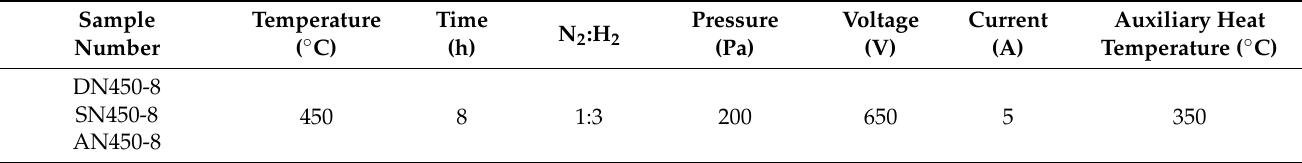
Table 2. Process parameters of low-temperature plasma